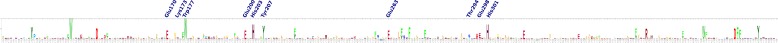
NrdBi HMMER sequence profile logo.Residues discussed in the results are marked in the figure with numbering according to L. blandensis NrdBi. Letter heights are proportional to probabilities for each amino acid at a given position, disregarding background probabilities. Total height of letters is proportional to information content in a given position. Generated with Skylign(Wheeler et al., 2014).